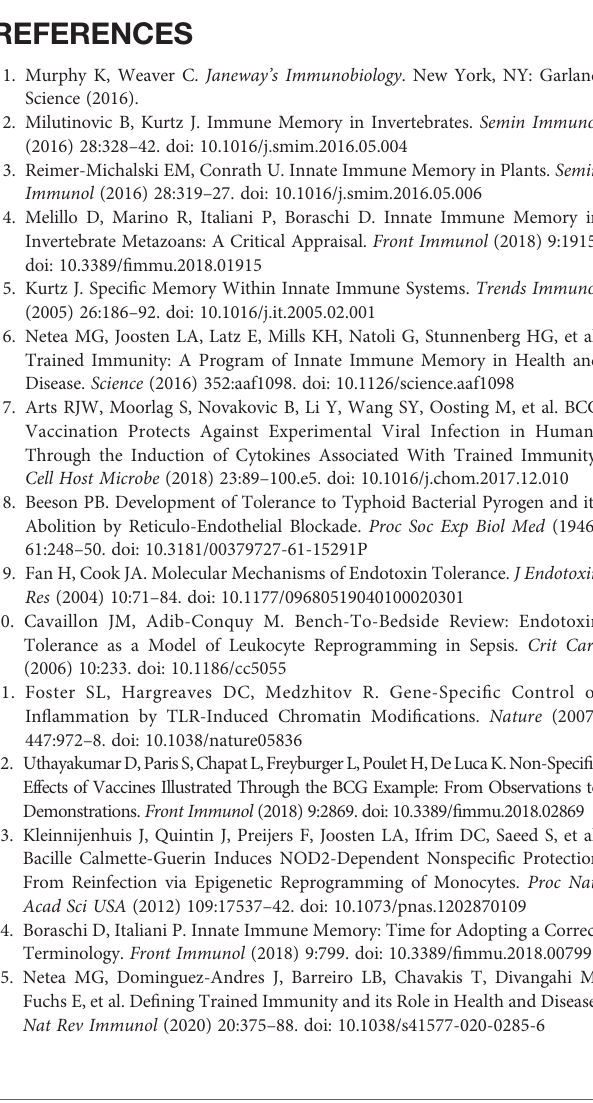
production of IL-6 (A) , IL-1Ra (B) and MCP-1/CCL2 (C) and expressed as ng/106 monocyte. Values from individual donors are depicted concurrent with mean cytokine production. Relevant p values are indicated when < 0.05. n = 4. Supplementary Figure 2 | Effect of AuNPs on the memory response of monocytes primed by C. albicans . CD14+ monocytes were exposed to medium or C. albicans (ratio 0.1:1) for 24 h in the presence or absence of AuNPs (20 µg/mL, indicated by blue bars), then washed and rested for 6 days. After resting, cells were challenged with LPS (5 ng/mL) for 24 h. Supernatants were collected and cytokine production measured: IL-6 (A) , IL-10 (B) , IL-1Ra (C) MCP-1/CCL2 (D) , MIP-1/ CCL3 (E) , MIP-1b/CCL4 (F) , GROa/CXCL1 (G) , IP-10/CXCL10 (H) , IL-8/CXCL8 (I) . Individual donor values are depicted concurrent with mean cytokine production (ng/106 monocytes). n = 4. Supplementary Figure 3 | Effect of AuNPs on the memory response of monocytes primed by H. pylori . CD14+ monocytes were exposed to medium or H. pylori (at MOI 0.2) for 24 h in the presence or absence of AuNPs (20 µg/mL, indicated by blue bars), then washed and rested for 6 days. After resting, cells were challenged with LPS challenge (5 ng/mL) for 24 h, and supernatant were collected for evaluation of cytokines and chemokines: IL-1a (A) , IL-8/CXCL8 (B) , MCP-1/ CCL2 (C) , MIP-1a/CCL3 (D) , MIP-1b//CCL4 (E) , IP-10/CXCL10 (F) . Individual donor values are depicted concurrent with mean cytokine production (ng/106 monocytes). Relevant p values are indicated when < 0.05. n =